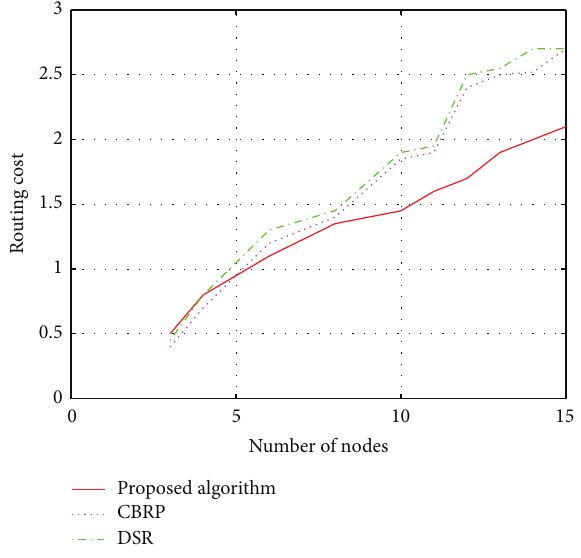
Figure 9: Proposed algorithm, CBRP, and DSR routing cost versus number of